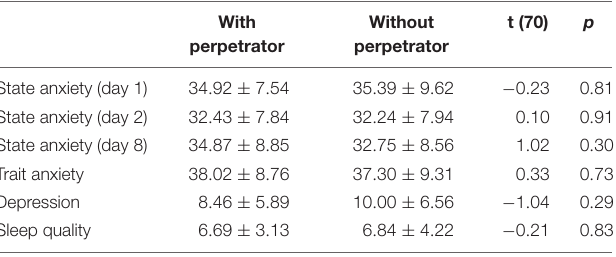
TABLE 2 | Symptomatology